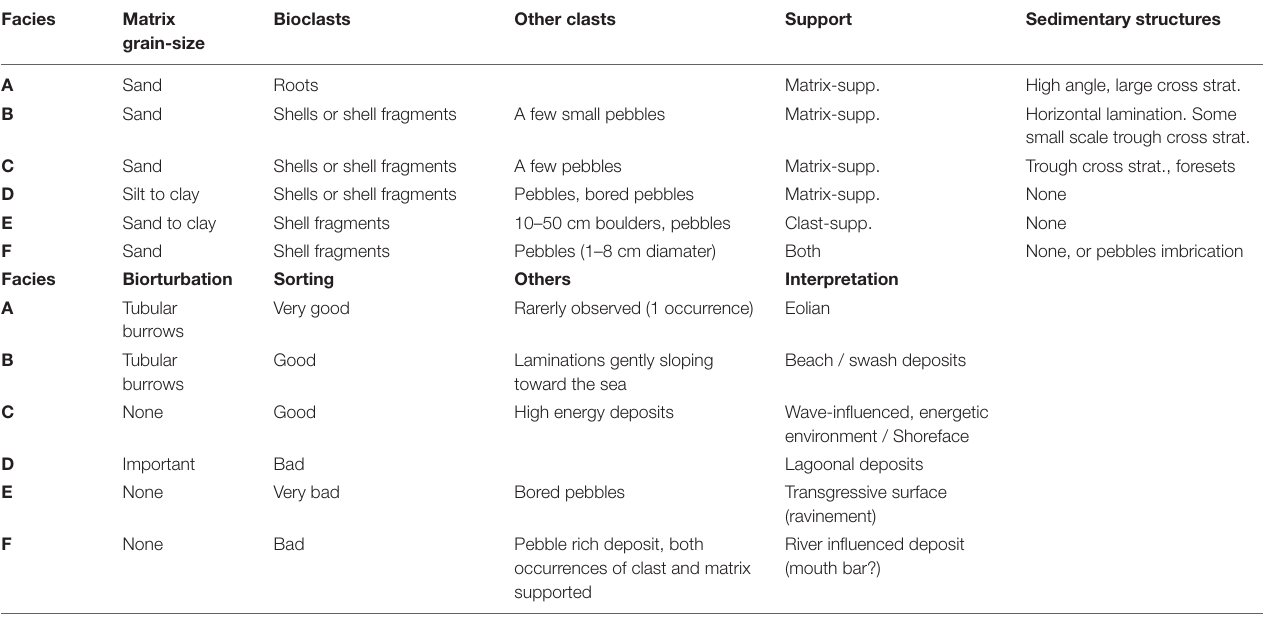
TABLE 1 | Facies encountered in the western Mmt sedimentary